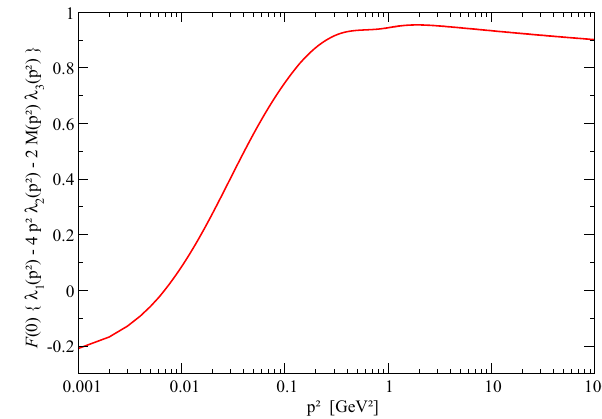
Fig. 3 Full QCD N f = 2 lattice 32 3 × 64 simulations for λ 1 ( p 2 ) for the Landau gauge [18] together with rescaled Landau gauge gluon propagator for pure Yang–Mills theory [24,25] and full QCD [26] for N f = 2